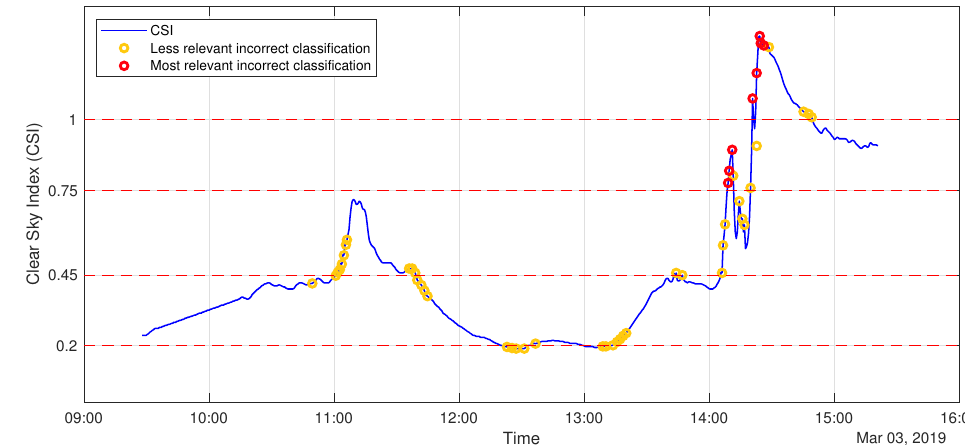
Figure 11. CSI trend with highlighted classification errors for the day of 3 March